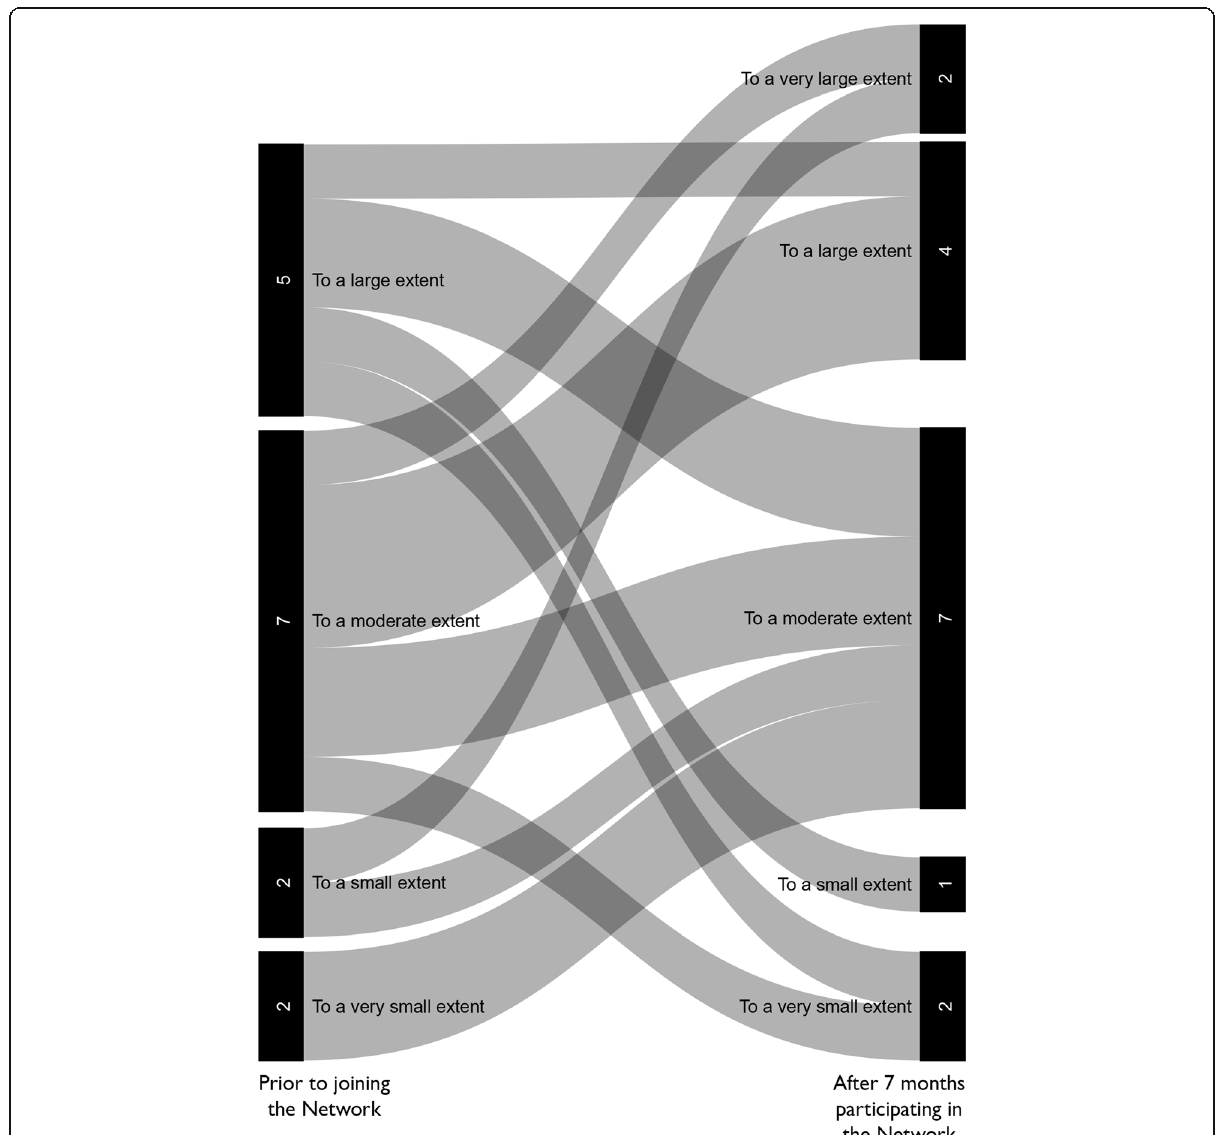
Fig. 5 Change in (STEM) 2 Network Participants ’ Feelings about being Change Agents. Change in reported sense of how prepared participants felt to be a change agent for STEM education reform over 7 months in the (STEM) 2 Network. Left most bars are prior to joining the Network. Right most bars are after 7 months in the